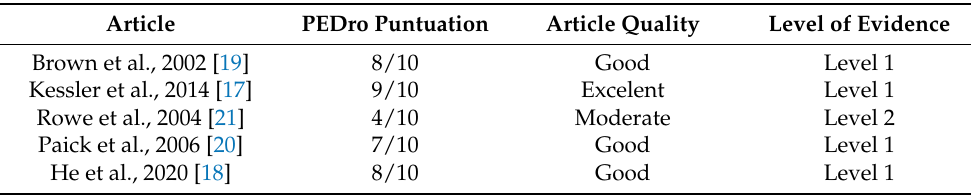
Table 3. Benefits of magnetic therapy, based on the level of evidence and grade of recommendation in CPP.